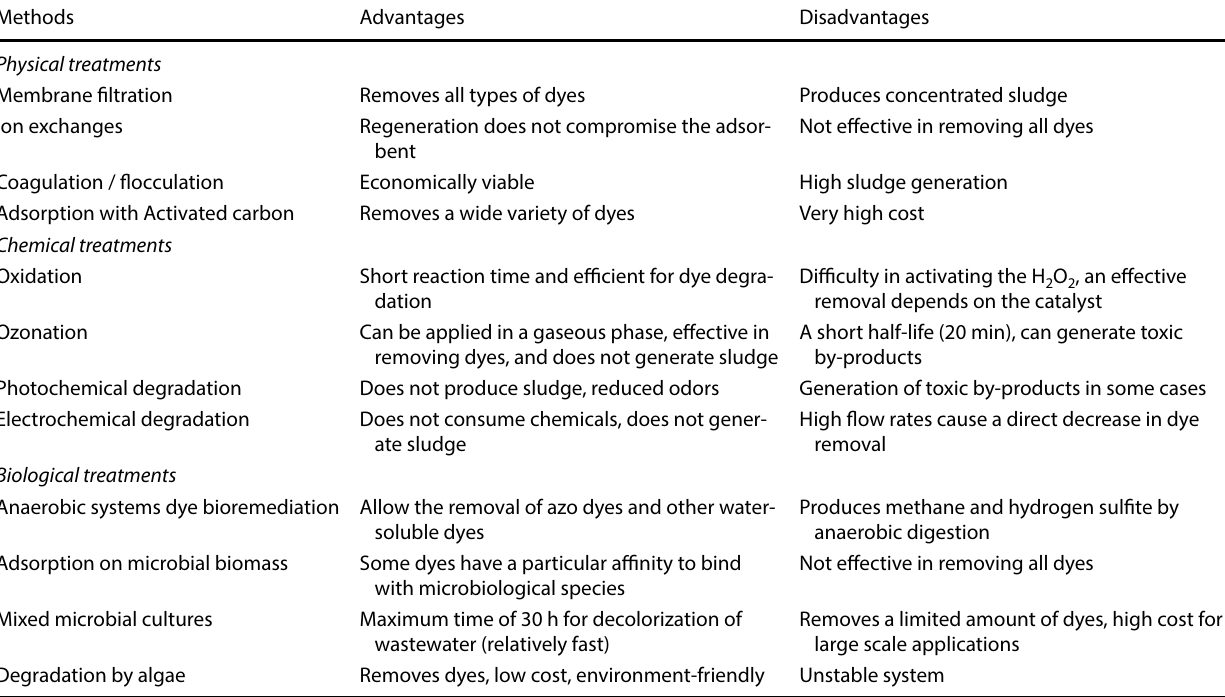
Table 2 Advantages and disadvantages of dye removal methods in water (adapted from [14, 21,